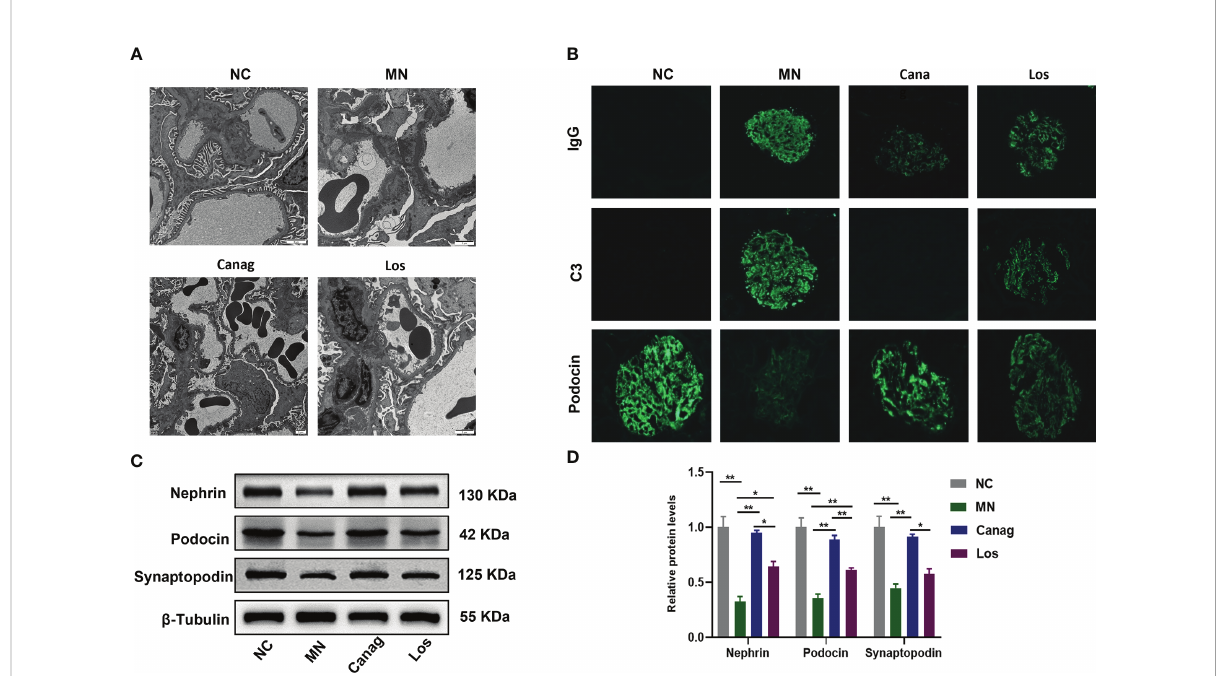
FIGURE 2 Canagli fl ozin inhibits renal immunity and alleviates podocyte injury in MN rats. (A) Representative TEM images of glomeruli. Scale bar, 2 m m. (B) Representative immuno fl uorescence images of IgG, C3, and podocin in glomeruli. Original magni fi cation ×400. (C, D) Western blots